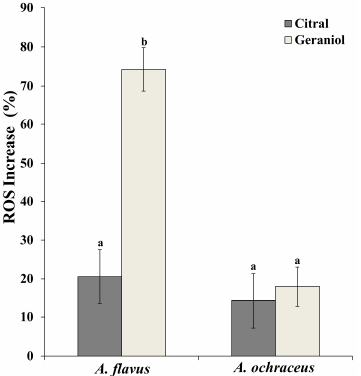
Figure 4. Effects of citral and geraniol on the increase of ROS in two Aspergillus spp . Data are the mean ± SD of three independent experiments. Columns with different letters at the same group indicate significant difference ( p < 0.05) according to unpaired Student’s t -test.